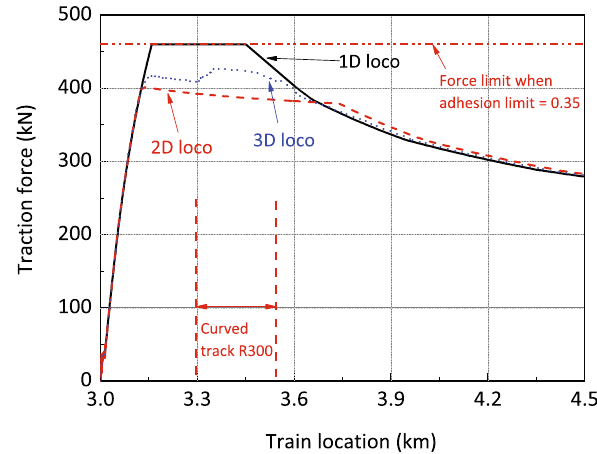
Fig. 6 Simulated traction forces of the leading locomotive